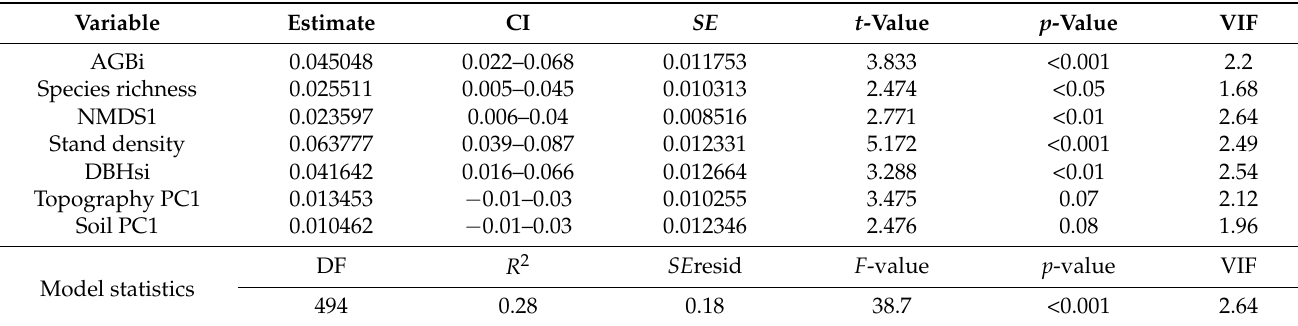
Table 1. Optimal spatial simultaneous autoregressive error model of species diversity, species composition, stand structural attributes, initial above-ground biomass, and environmental factors on forest